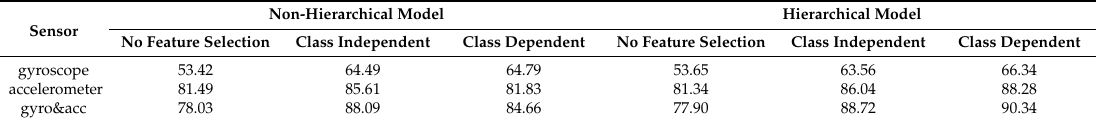
Table 6. A comparison of F1 between hierarchical and non-hierarchical